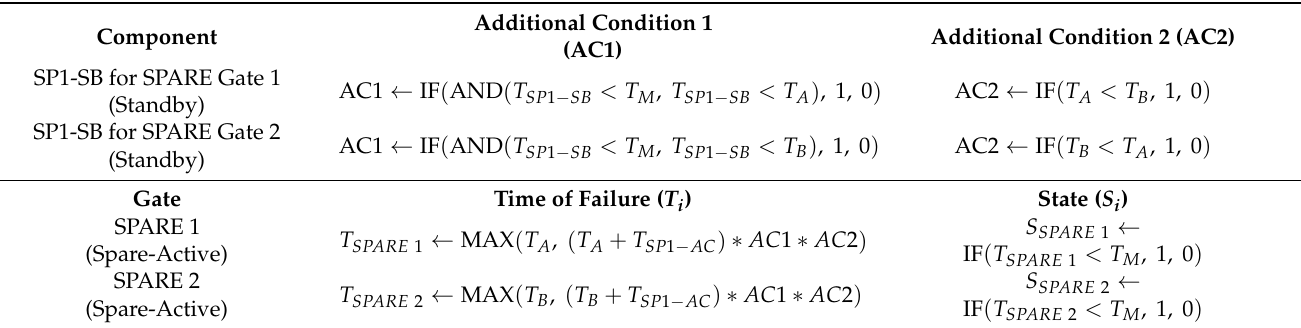
Table 6. Logical expression for deriving the output of two SPARE gates that share one component.